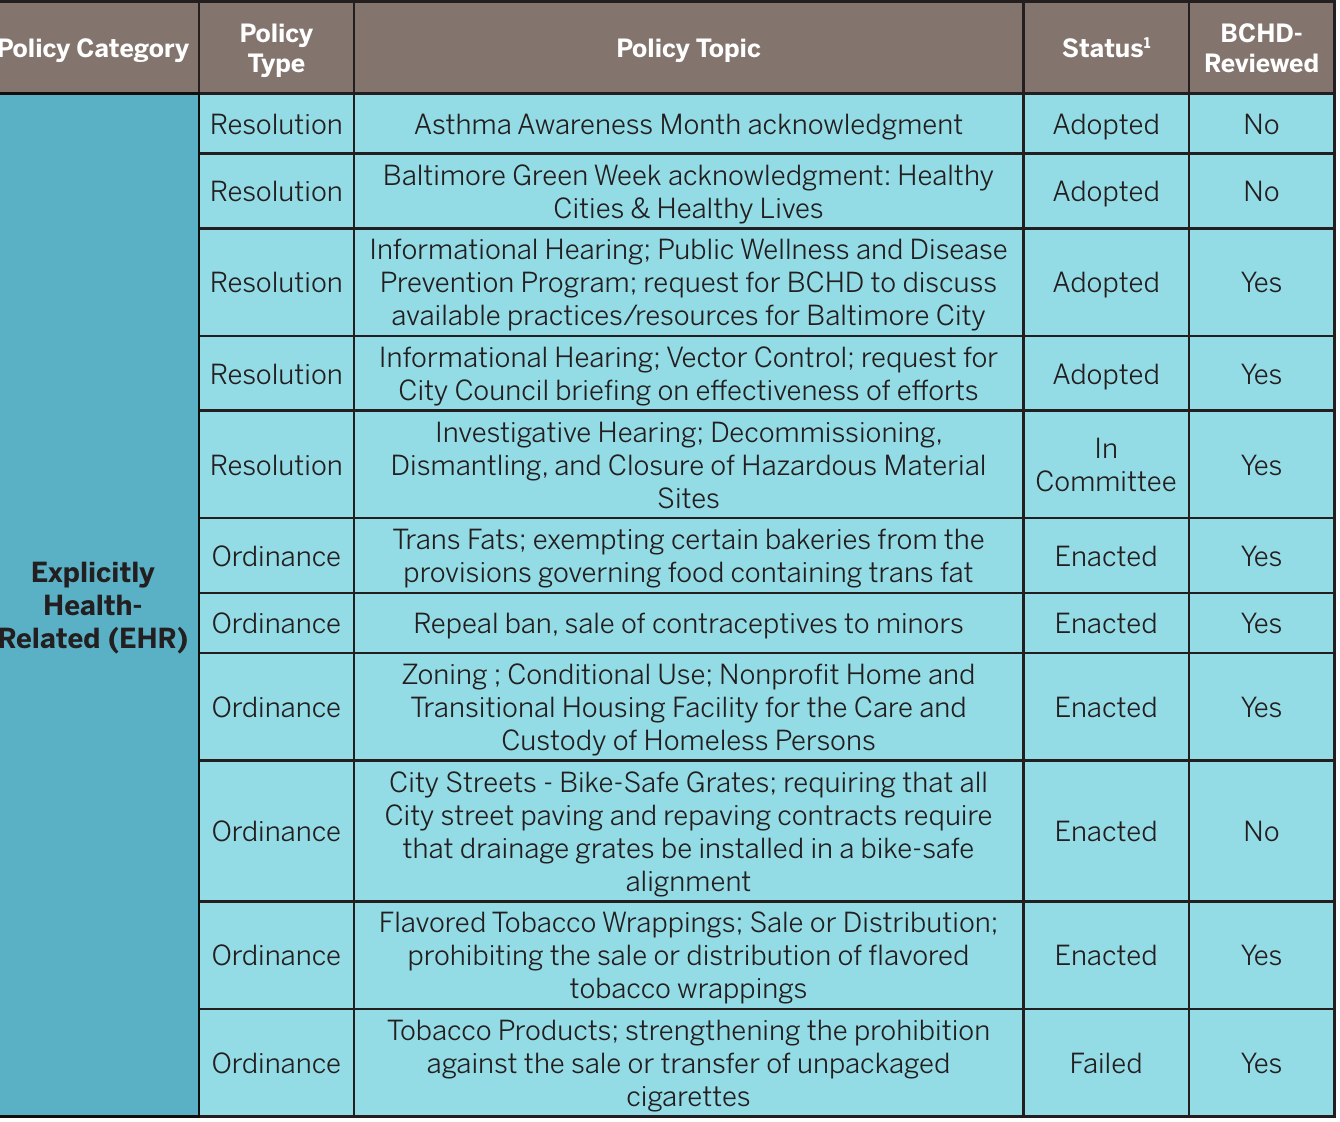
Table 1: 25 Illustrative Examples of Policies Reviewed & Categorized for Potential